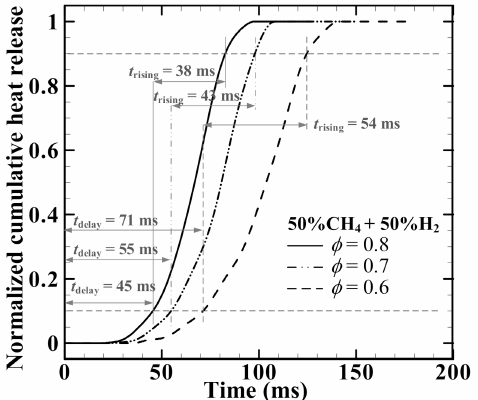
Figure 4. The normalized cumulative heat release (NCHR) for 50% CH 4 /50% H 2 /air at different equivalence ratios, φ = 0.6, 0.7, and